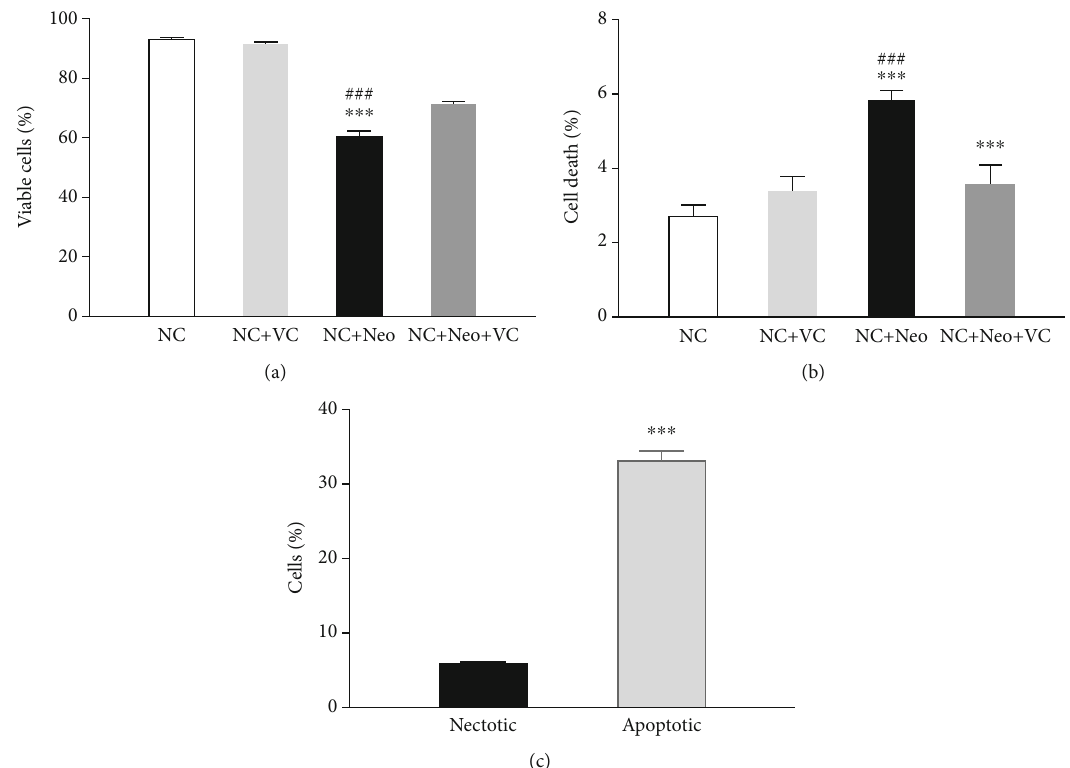
Figure 4: Percentage of viable and damaged cells treated with VC and neomycin. Viable and dead cells were measured with fl ow cytometry. (a) Percentage of viable cells in various treatment groups. (b) Percentage of death cells with neomycin and VC treatment. One-way ANOVA, ∗∗∗ p < 0 : 001 versus NC group and ### p < 0 : 001 versus NC+Neo+VC group. (c) Percentage of necrotic and apoptotic cells exposed to neomycin, two-tailed, unpaired t -test, ∗∗∗ p < 0 : 001 . All tests were repeated four times